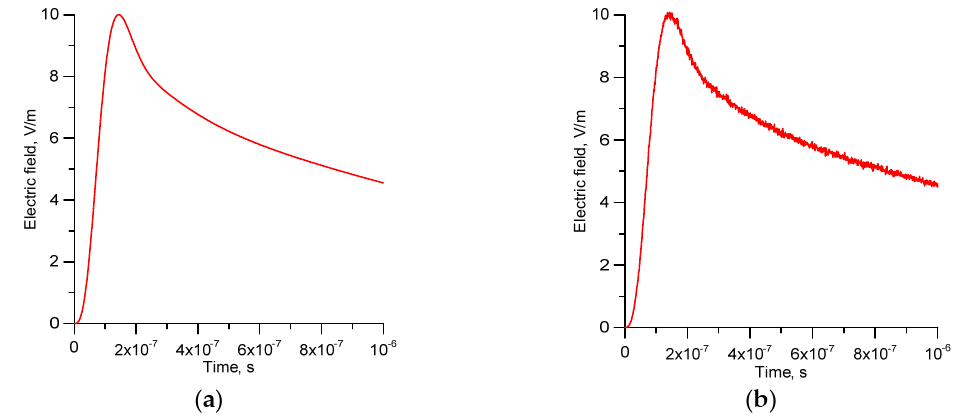
Figure 14 . ( a ) Electric radiation field at 100 km without taking into account the randomness of the growth curve; ( b ) electric radiation field at 100 km taking into account the randomness of the growth curve.